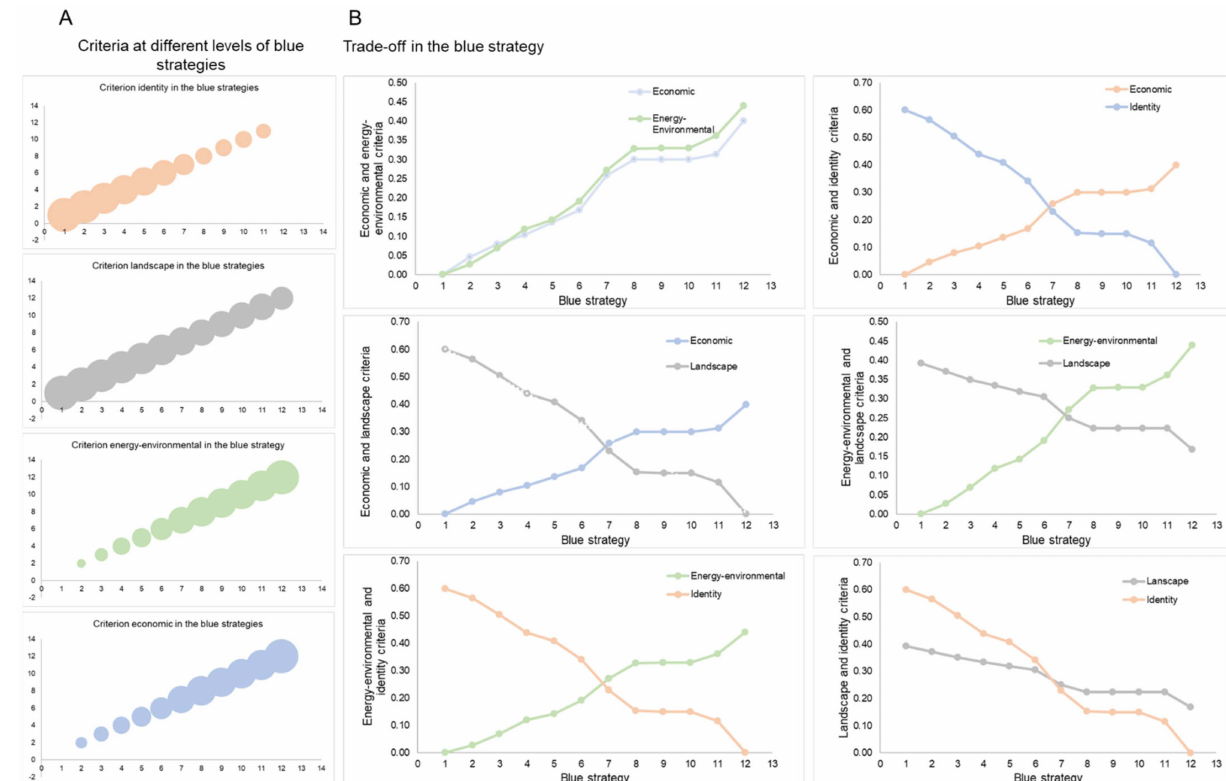
Figure 6. Ranking of interventions for the different levels of the blue strategy based on the NPV–NPV in the different levels of the blue strategy.